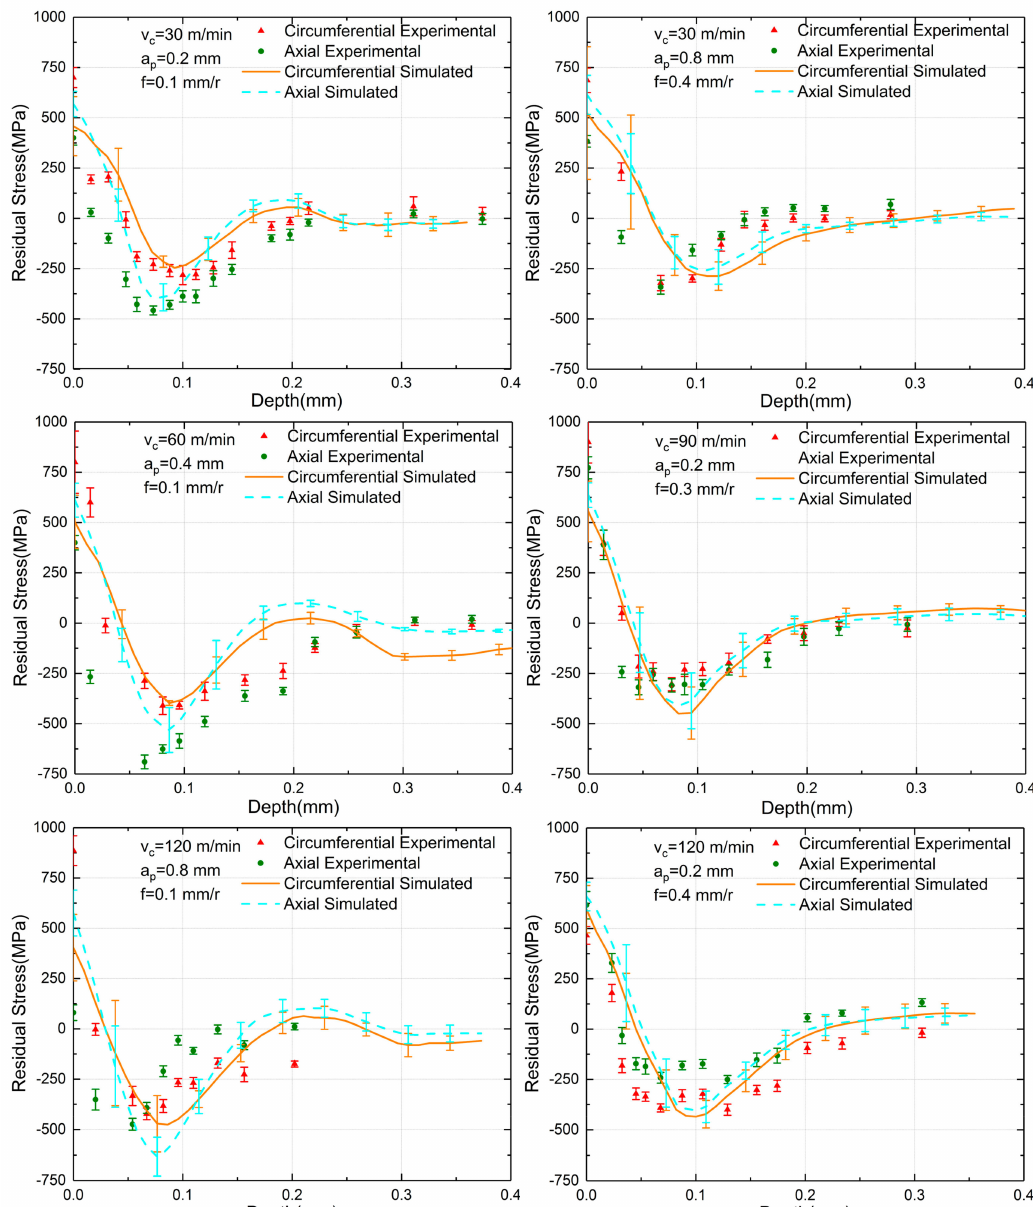
Figure 8. The comparation of experimental and simulated residual stress